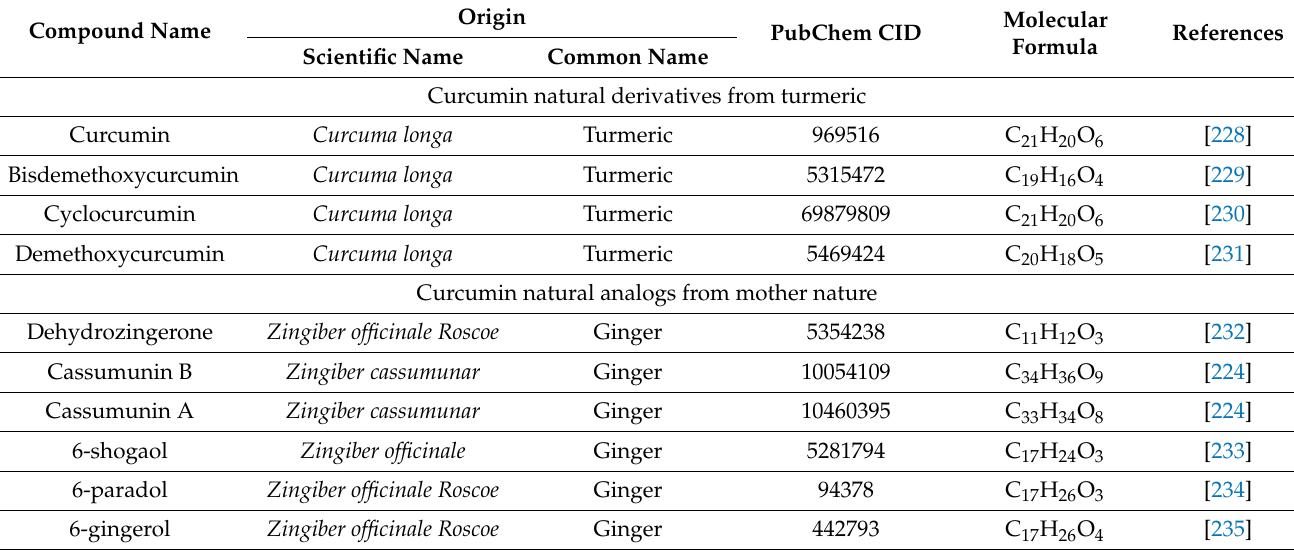
Table 5. List of natural derivatives and analogs of